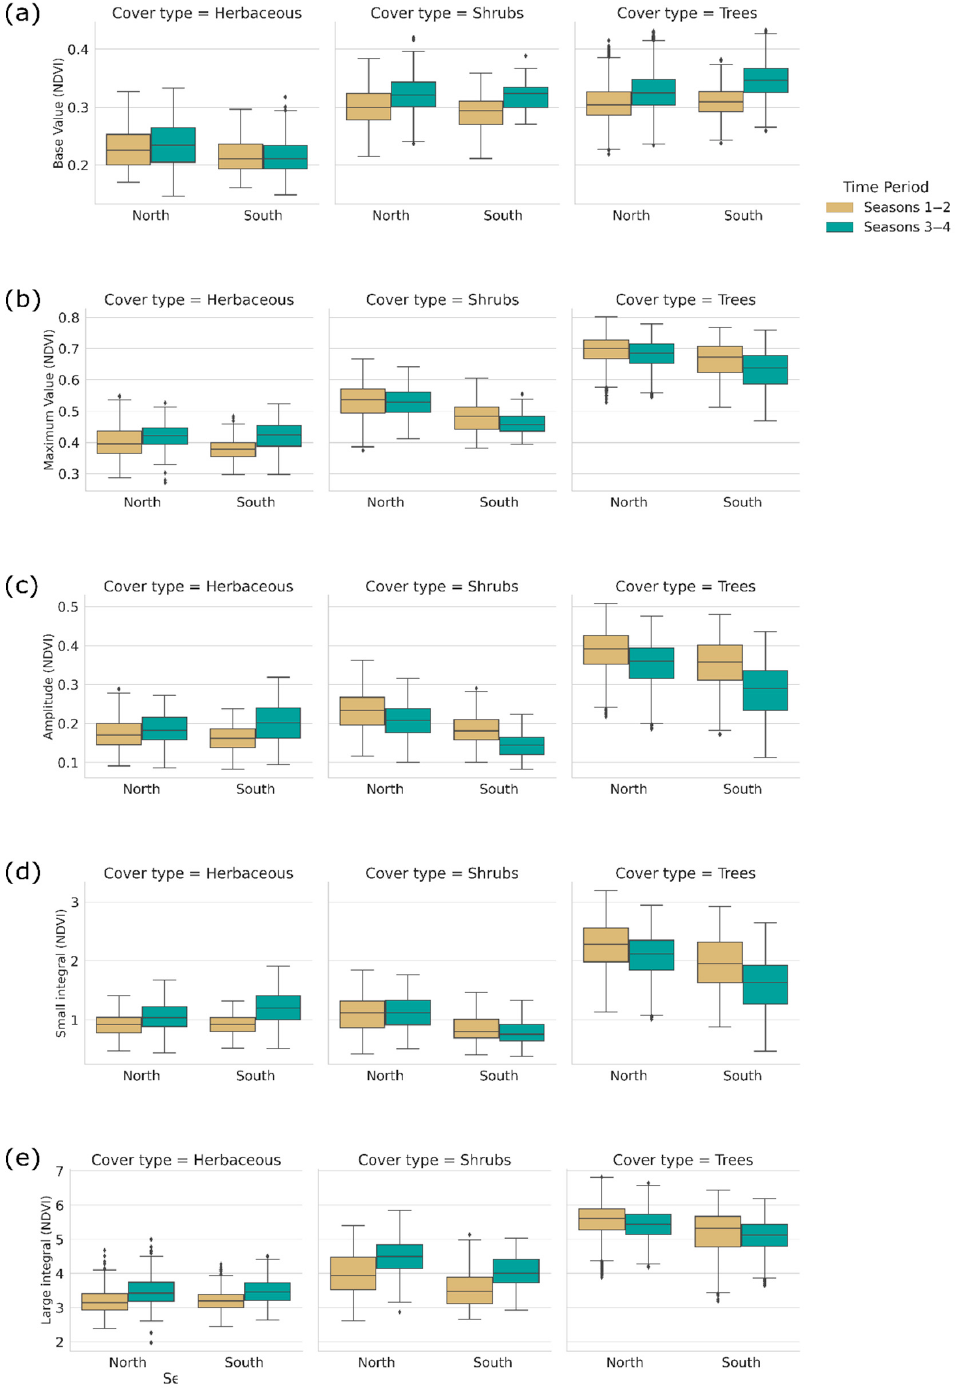
Figure A4. Changes in productivity metrics during the study period. Boxplots show the distribution of the values of the pixels averaged for the two seasons in each time interval (seasons 1–2 vs. seasons 3–4) for the metrics: ( a ) base value, ( b ) maximum value, ( c ) amplitude, ( d ) small integral, and ( e ) large integral.